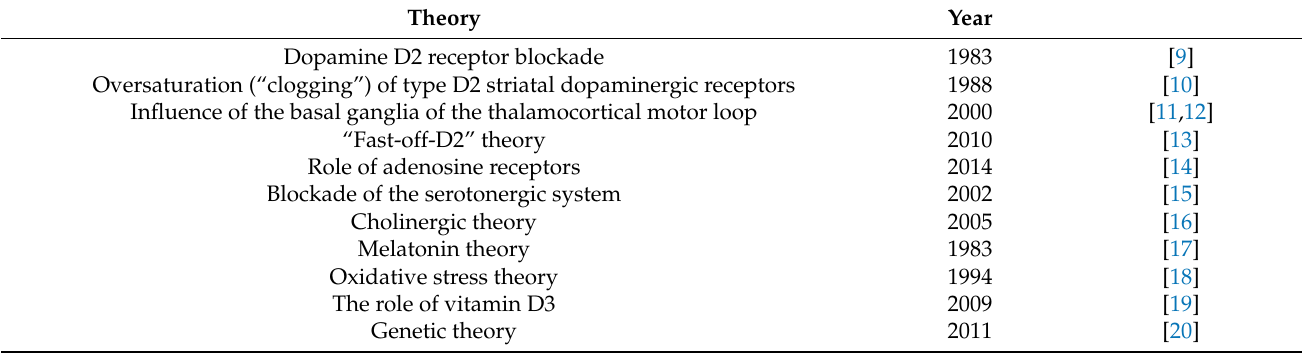
Table 1. Mechanisms of development of antipsychotic-induced parkinsonism [7].